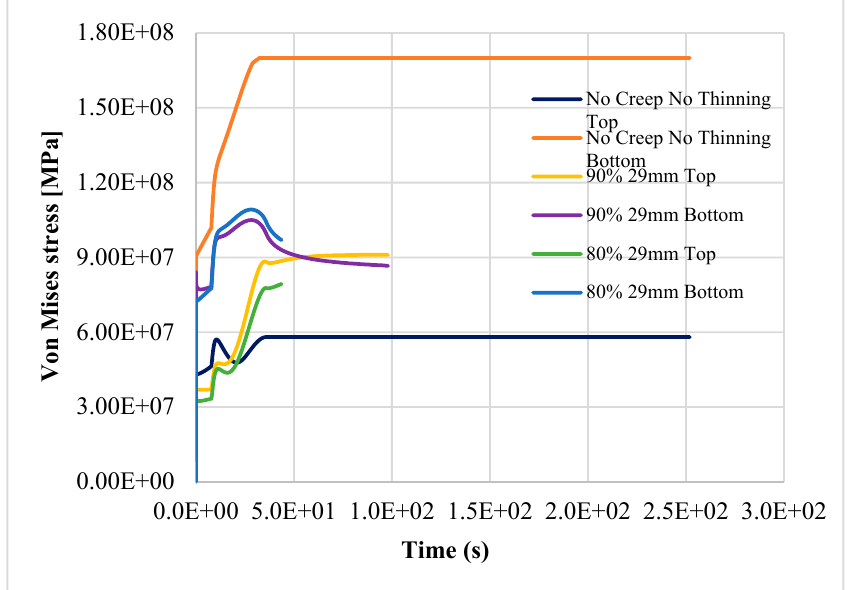
Figure 9. Top and bottom equivalent layers of equivalent von Mises stress away from thinning—case 1 (reference), case 4, case 5.